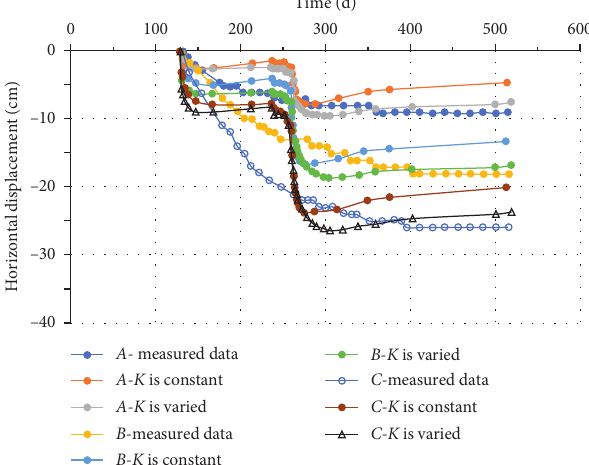
Figure 10: Comparison of the monitoring values and the nu- merical calculations of the ground horizontal